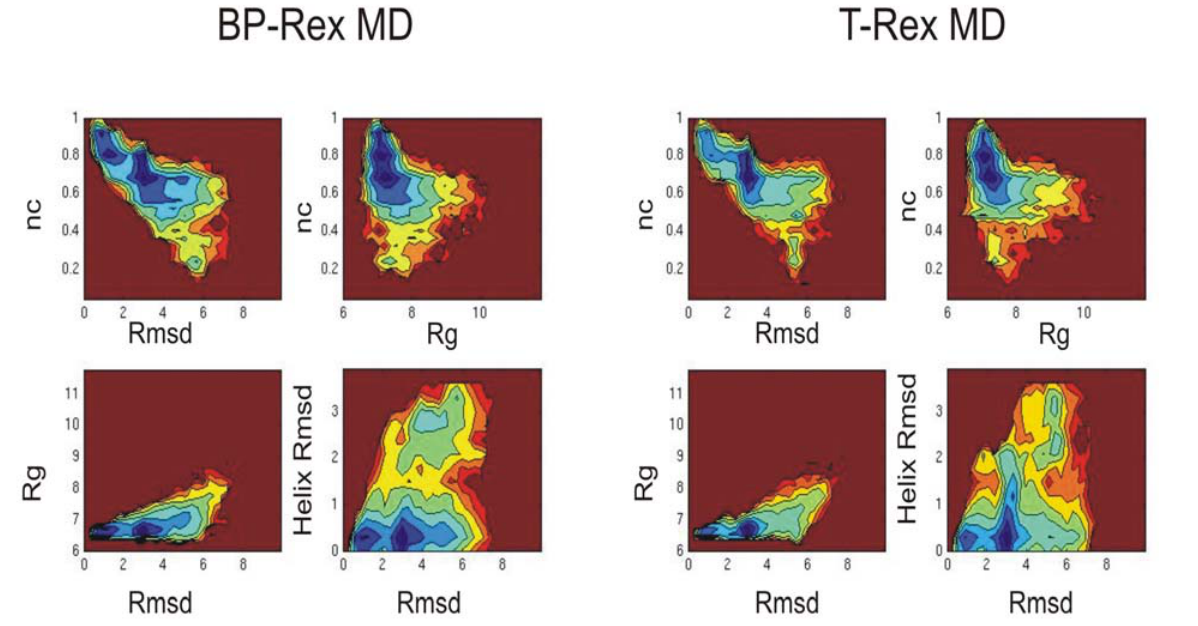
Figure 4. Free energy landscape for the Trp-cage conformations sampled in the reference replica during BP-RexMD and T-Rex MD simulations projected onto various combinations of the number of native contacts (nc), backbone Rmsd (Rmsd and Rmsd (in Å) of the residues 2-8 from an α -helical structure. The logarithm of C α sampling density (low free energy) increases from red to